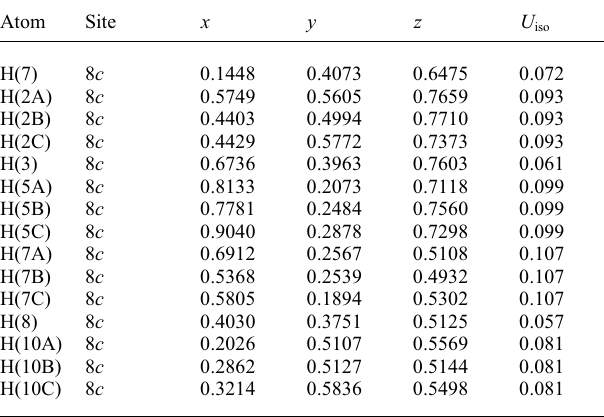
Table 2. Atomic coordinates and displacement parameters (in Å 2 )